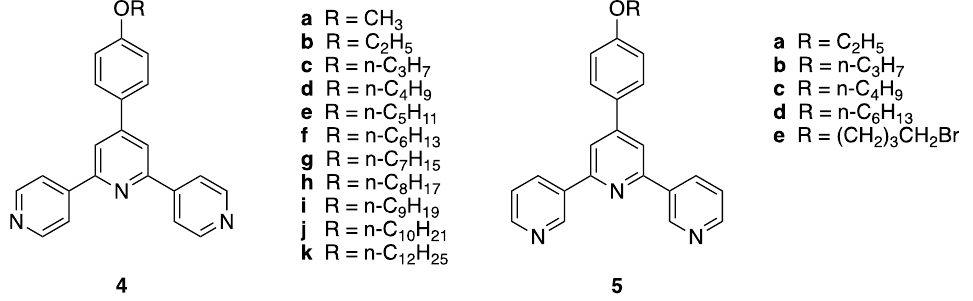
Figure 2. Structures of 4′ -(4-alkyloxyphenyl)-4, 2′ : 6′ ,4 ′′ -terpyridines and 4′ -(4-alkyloxyphenyl)-3, 2′ : 6′ ,3 ′′ -terpyridines. Compounds 5a-c are the subject of this publication. 2.2. Results 2.2.1. 4 ′ -(4-Ethoxyphenyl)-3,2 ′ :6 ′ ,3 ′′ -terpyridine and 4 ′ -(4-butoxyphenyl)-3,2 ′ :6 ′ ,3 ′′ -terpyridine